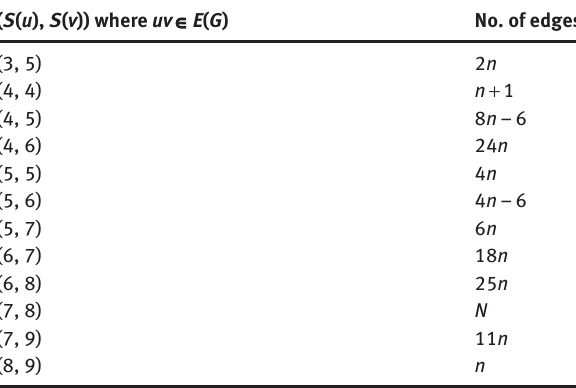
Table 3: Edge set partition of porphyrin dendrimer D sum of degrees of vertices adjacent to end vertices of every